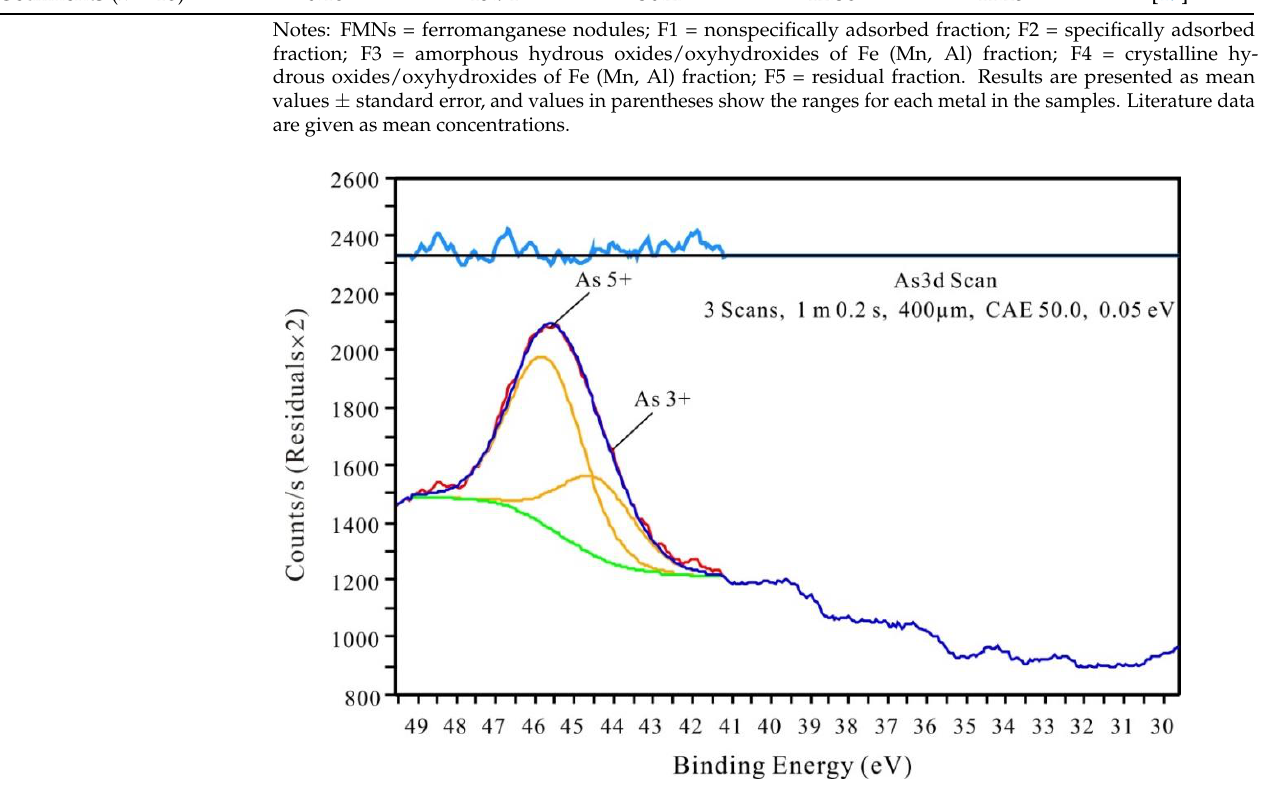
Figure 2. High-resolution XPS spectrum of As3d in the ferromanganese nodule powder. Table 4. As 2p 3/2 electron binding energy and atomic percentages.